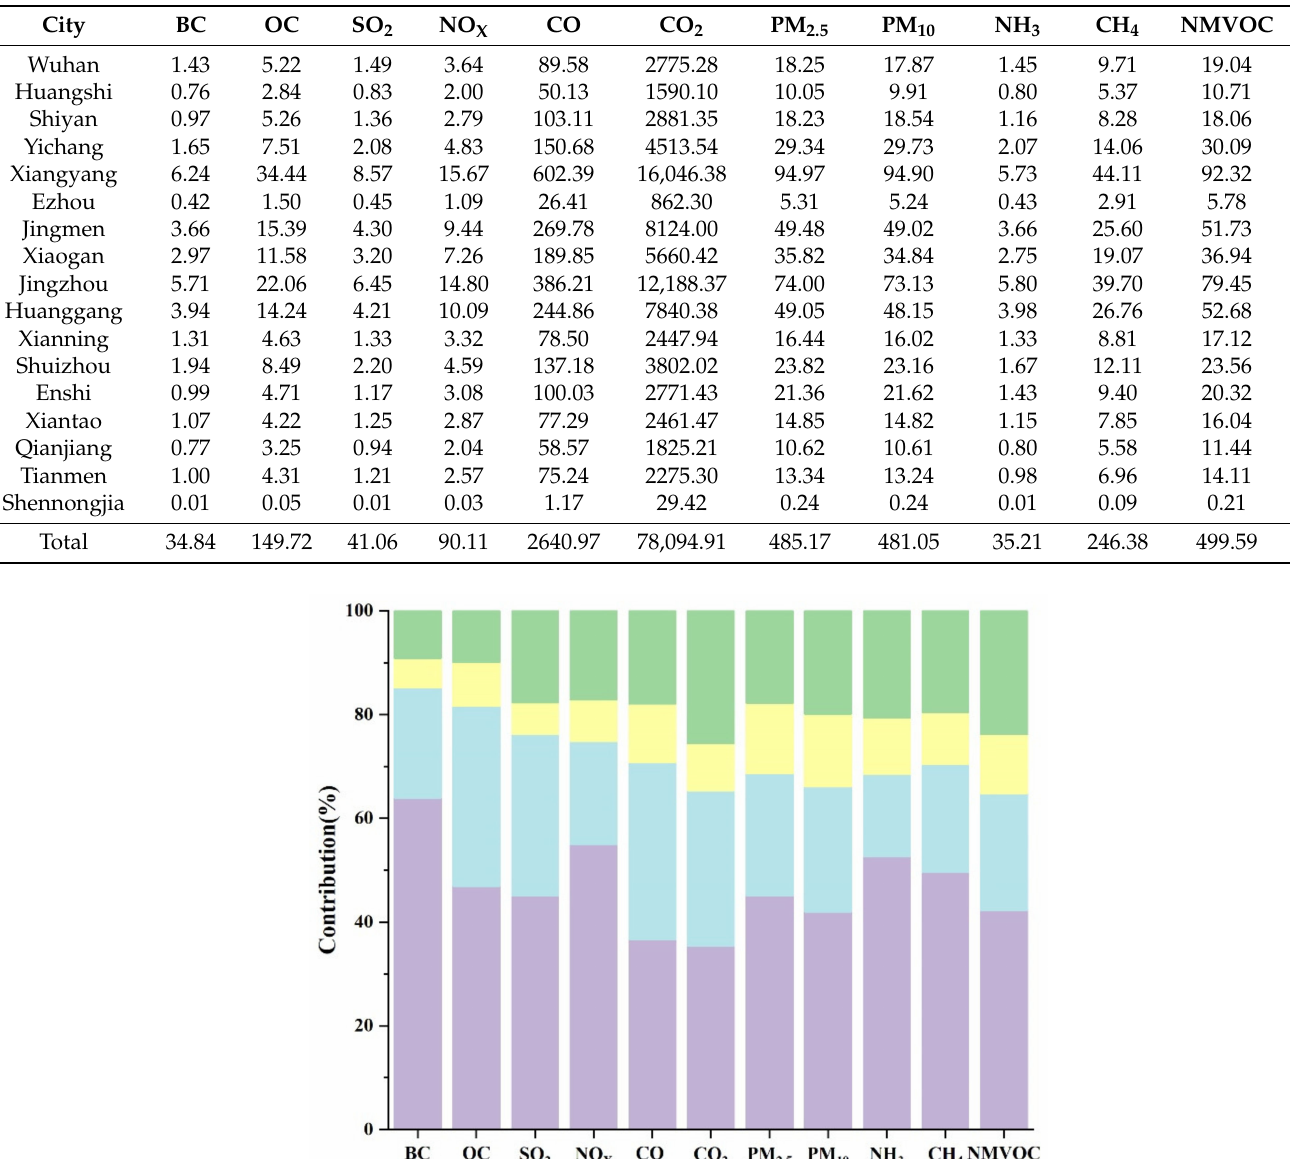
Table 5. Emission inventory of crop residue open burning in Hubei during 2012–2020 (Gg).